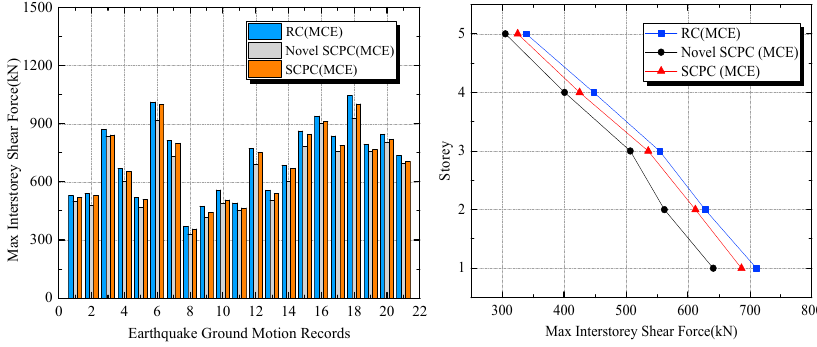
Figure 26. Maximum inter-story shear force of three frames at MCE level.